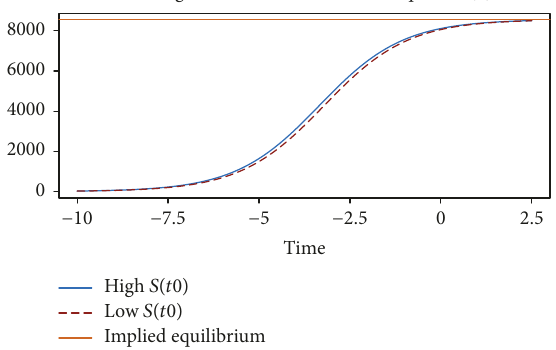
Figure 6: Time plot of raw data and the forecasts of model D and the martingale.